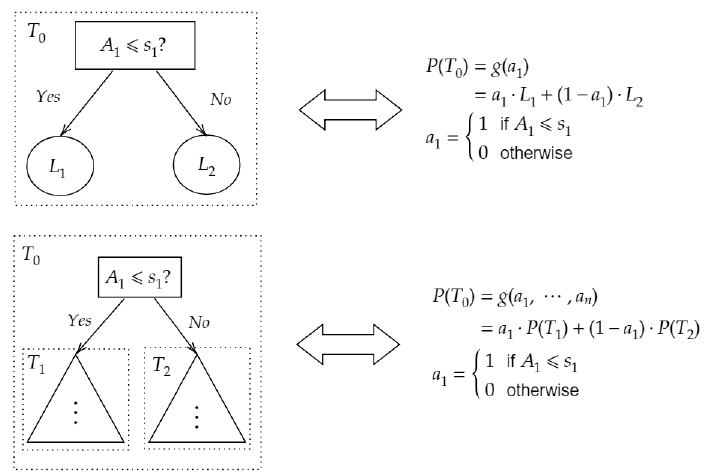
Figure 3. Transformation between Decision Tree and